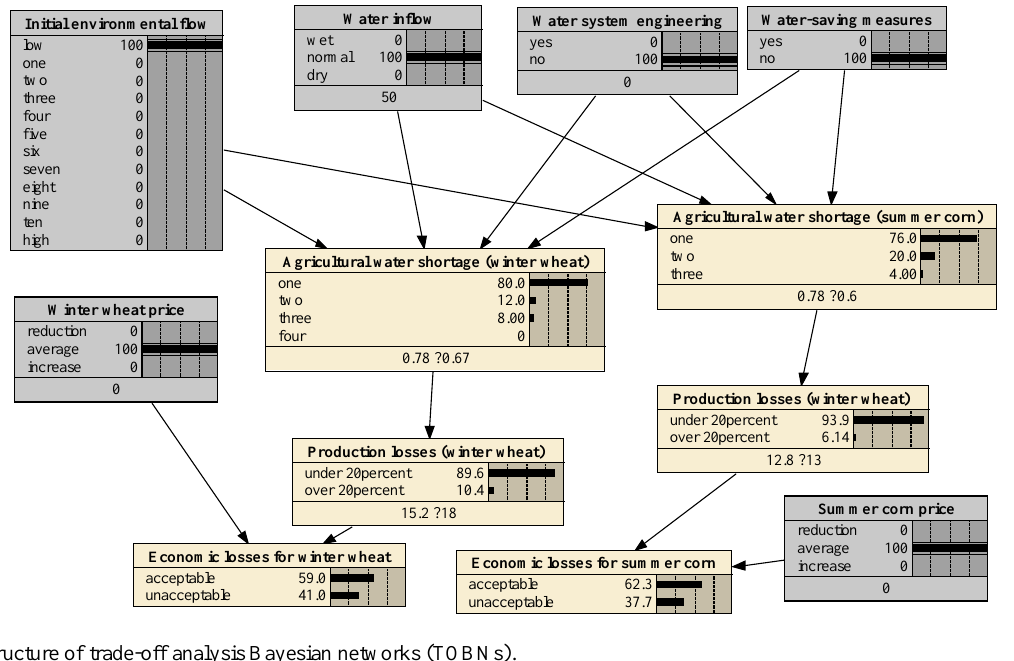
Fig. 6. The structure of trade-off analysis Bayesian networks (TOBNs).